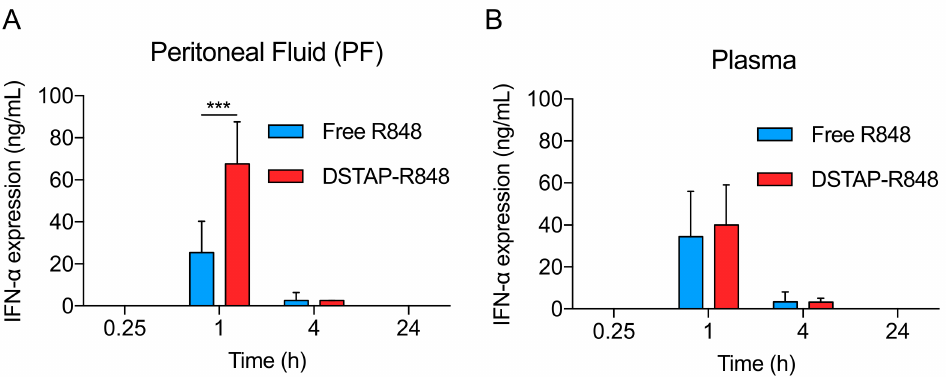
Figure 3. IFN- α levels in the ( A ) peritoneal fluid, ( B ) plasma after IP administration of free R848 and DSTAP-R848 in mice. (Data = mean ± SD, n = 5, ***: p <